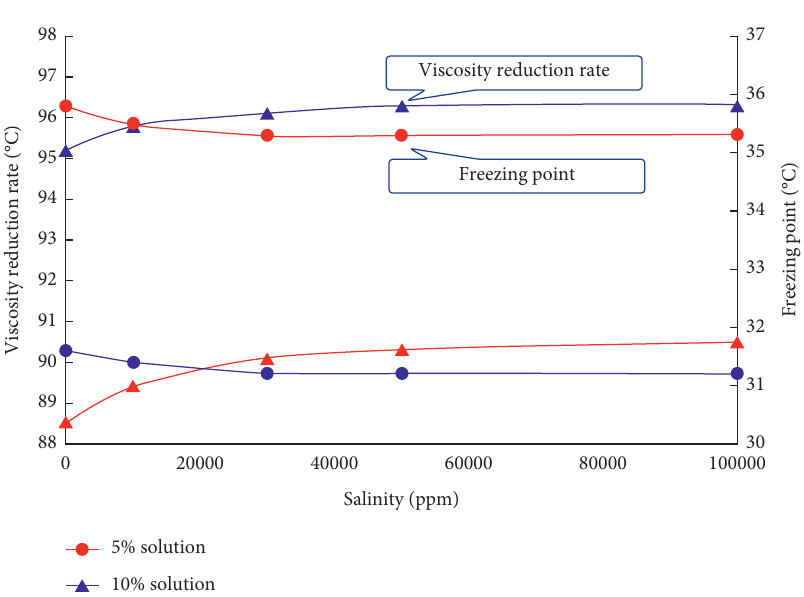
Figure 5: Influence of salinity on viscosity reduction rate and freezing point of PD-7.